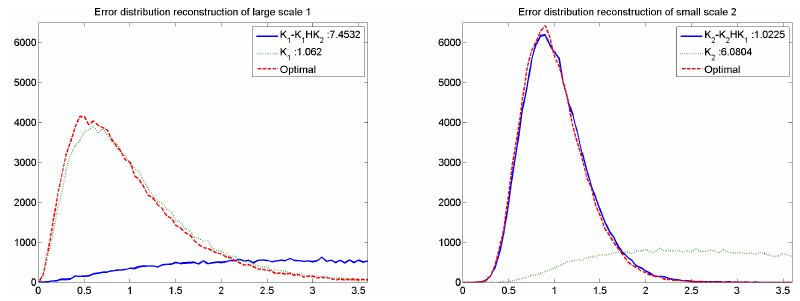
Figure C1. Histogram of scaled errors for reconstruction of process 1 (left) and process 2 (right). We see that for process 1, it is better to use the full data set, whereas for process 2 it is better to work with residuals, i.e., data from which we subtract the analysis of the process 1.